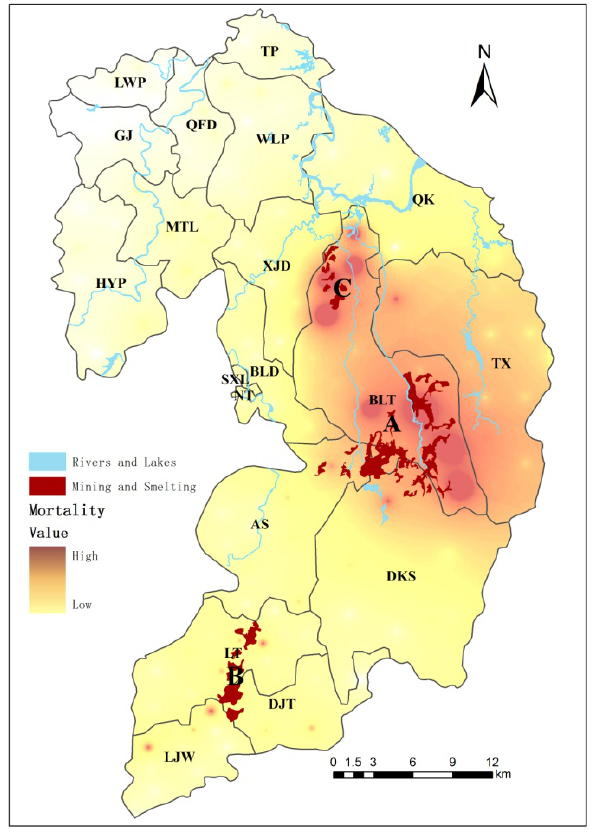
Figure 4. Geographical distribution of mortality levels in Suxian District of Chenzhou City, South China.